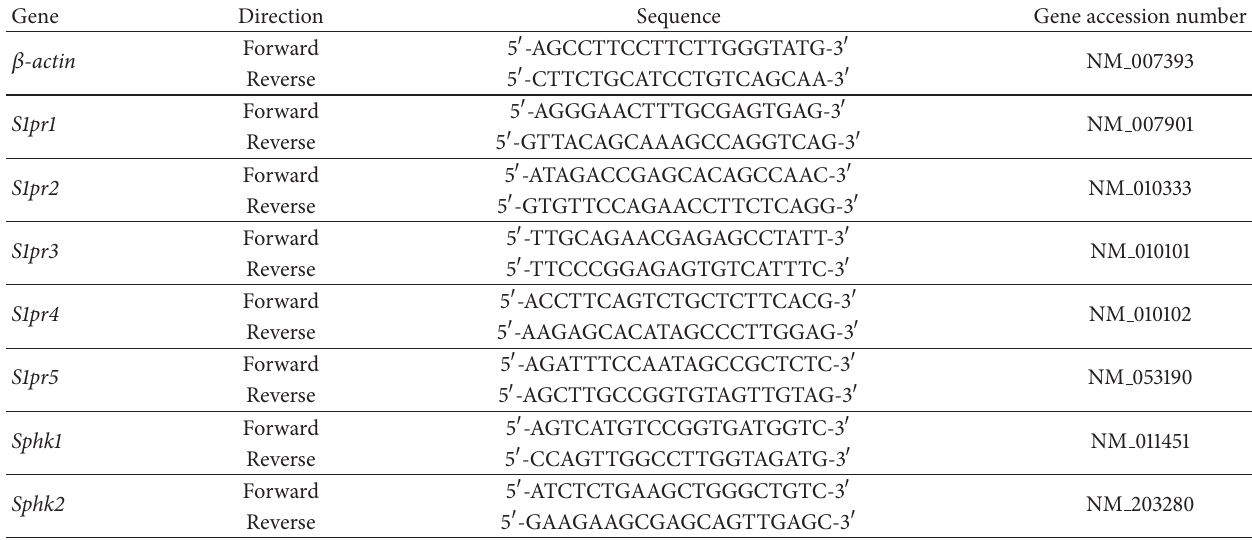
Table 1: Primers used for PCR